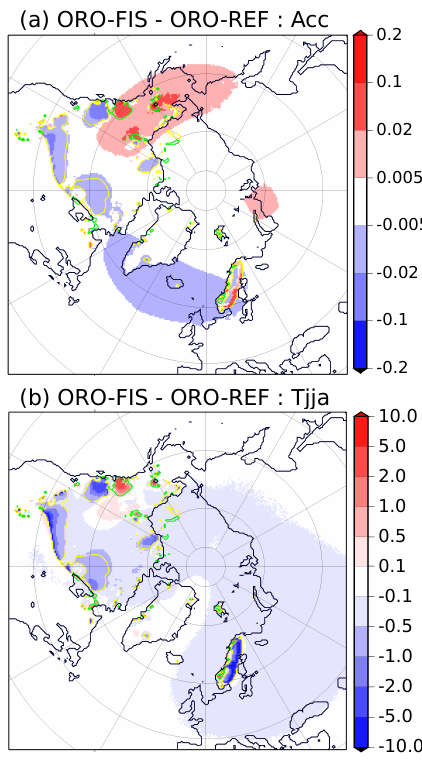
Fig. 8. (a) Accumulation difference (in meter water equivalent) be- tween ORO-FIS and ORO-REF at 80ka. The yellow line is the limit where the thickness difference exceeds 500m, the green one where the difference is under − 500m. (b) Summer temperatures differ- ences between ORO-FIS and ORO-REF at 80ka (in ◦